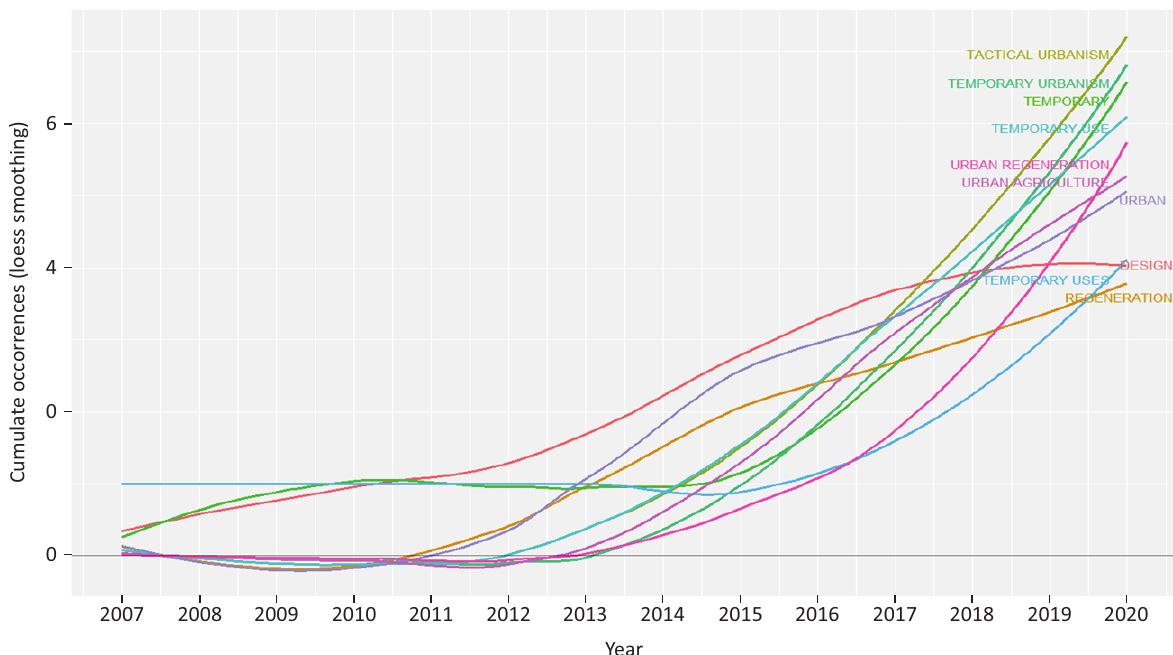
Figure 6. Growth of cumulative occurrences for top signifieds from titles, abstracts, and keywords, featuring topic of TU from 2007 until